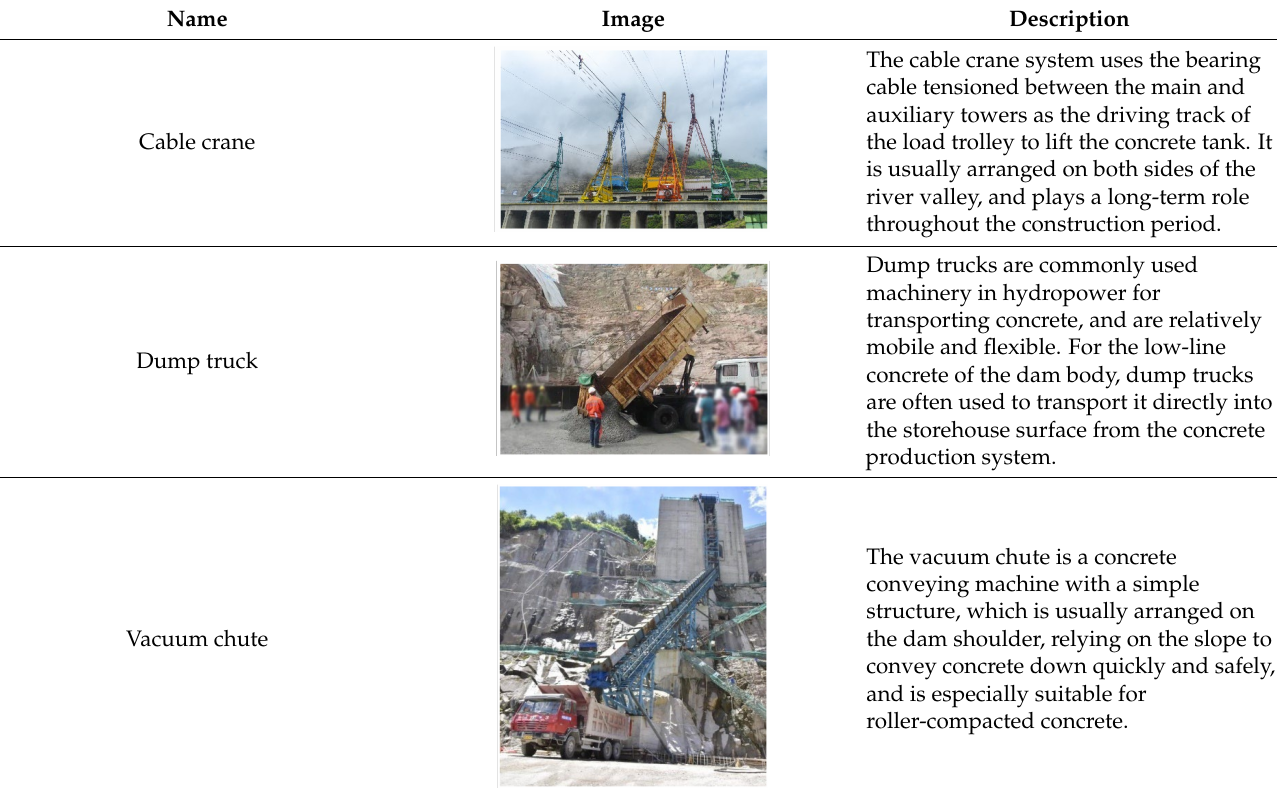
Table 5. Table of machinery used for pouring concrete in the Y2